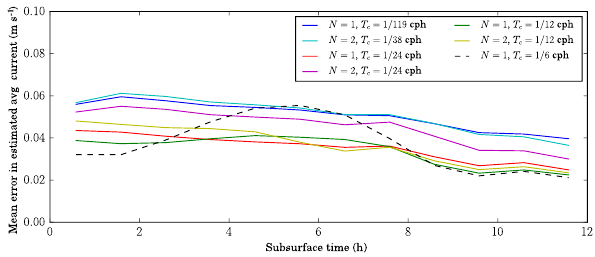
Figure 9. Mean error in estimated resurfacing position as a func- tion of subsurface time for various Butterworth low pass filters with order N and cut-off frequency 1 /T c